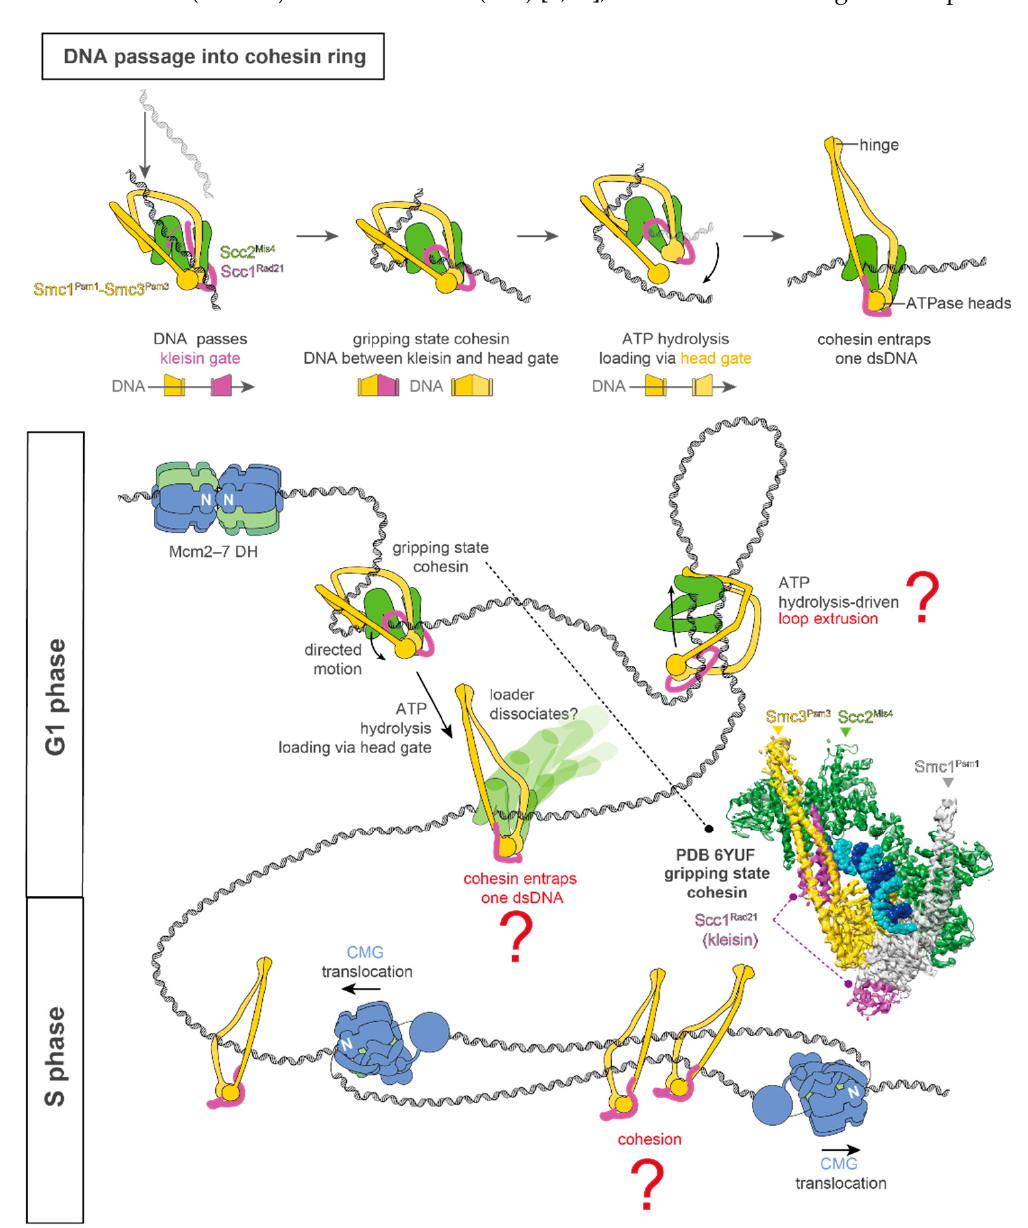
Figure 1. CMG formation and cohesin function in the G1 and S phases. At the top, model for DNA entrapment by cohesin. DNA is threaded through the open kleisin gate. In the ATP-stabilised “gripping” state, DNA is trapped between the kleisin and ATPase gates, while a DNA loop forms between the z-shaped cohesin loader (in green) and the cohesin hinge. ATP hydrolysis leads to the opening of the ATPase gate and ejection of the gripped DNA segment. As a result, the looped DNA remains entrapped within the cohesin ring. At the bottom, cohesin loading and loop extrusion at the origin of replication. During the G1 phase of the cell cycle, two MCM rings are loaded in a sequential manner, forming one DH on duplex DNA. Cohesin loading transitions via an ATP-binding-dependent intermediate, dubbed gripping state (cryo-EM structure is shown on the right). Following ATP hydrolysis, if DNA is directed through the ATPase head gate, cohesin could entrap duplex DNA within the Smc ring on the path to cohesion establishment. Alternatively, if DNA does not enter the cohesin ring, ATP hydrolysis may power loop extrusion. In the S phase, the CMG helicase is assembled, and translocation is induced with the N-terminal domain of MCM first. Cohesin transitions from parental duplex DNA to two duplicated sister